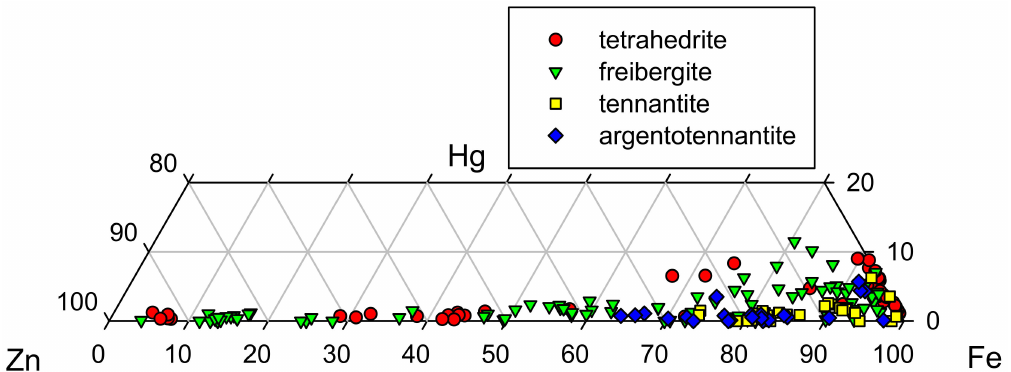
Figure 14. Graph of Ag vs. Cu ( apfu ) for members of the tetrahedrite group from the Kremnica deposit.